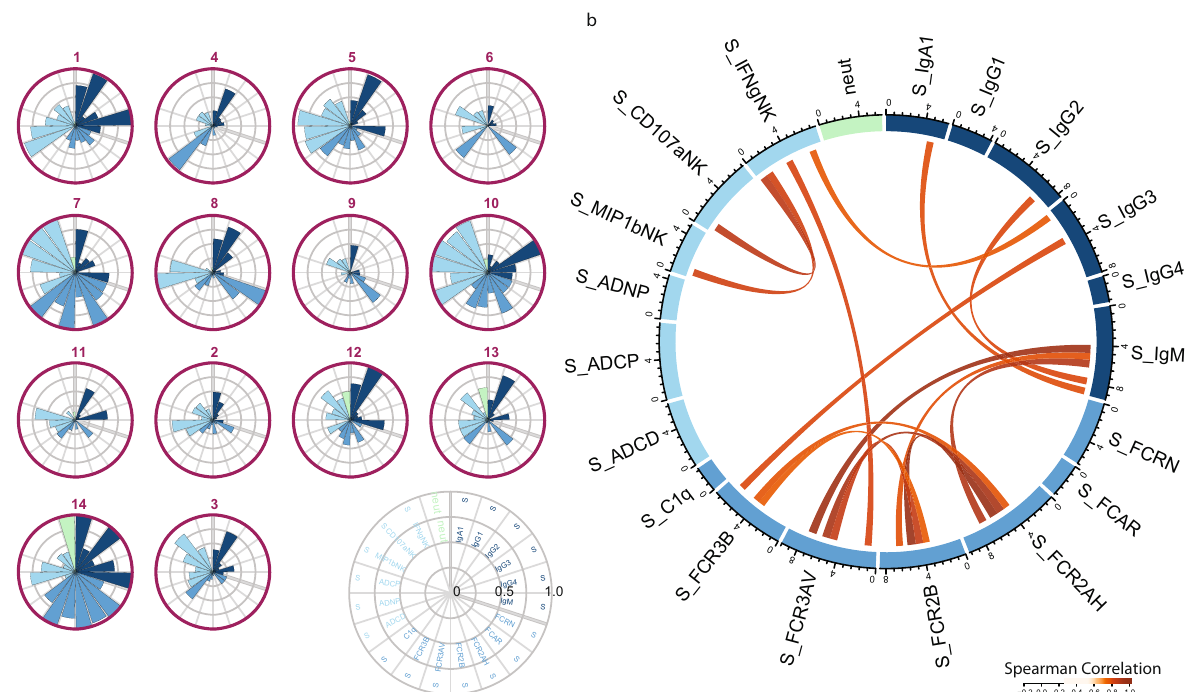
Fig. 1 Heterogeneity of anti-spike antibody pro fi les in convalescent plasma was not captured by neutralizing antibody titer. CP units were pro fi led for SARS-CoV-2S-speci fi c antibody responses. a Each polar plot depicts an individual donor ’ s anti-Spike antibody pro fi le, scaled to the minimum and maximum of the 14 CP units pro fi led. Each wedge represents a SARS-CoV-2 antibody feature, and the size of the wedge indicates the magnitude of the value. The colors represent the feature group: dark blue — antibody isotypes and subclasses; blue — Fc-receptor binding levels; light blue — antibody-dependent functions; light green — neutralizing antibody titer. b Cord diagram representing the statistically signi fi cant correlation among S-speci fi c antibody features in CP units with Spearman correlation> 0.5 and two-sided p -value < 0.05. The width of antibody each feature represents the accumulated values of Spearman correlation coef fi cients of that feature with all other features included in the diagram. The color of the cord represents the strength of Spearman correlation, with a higher correlation having darker red values. Source data are provided as a Source Data fi (day − 1) plasma pro fi les of CP recipients to the CP units they received (Fig. 2a). While variation was observed across CP reci-